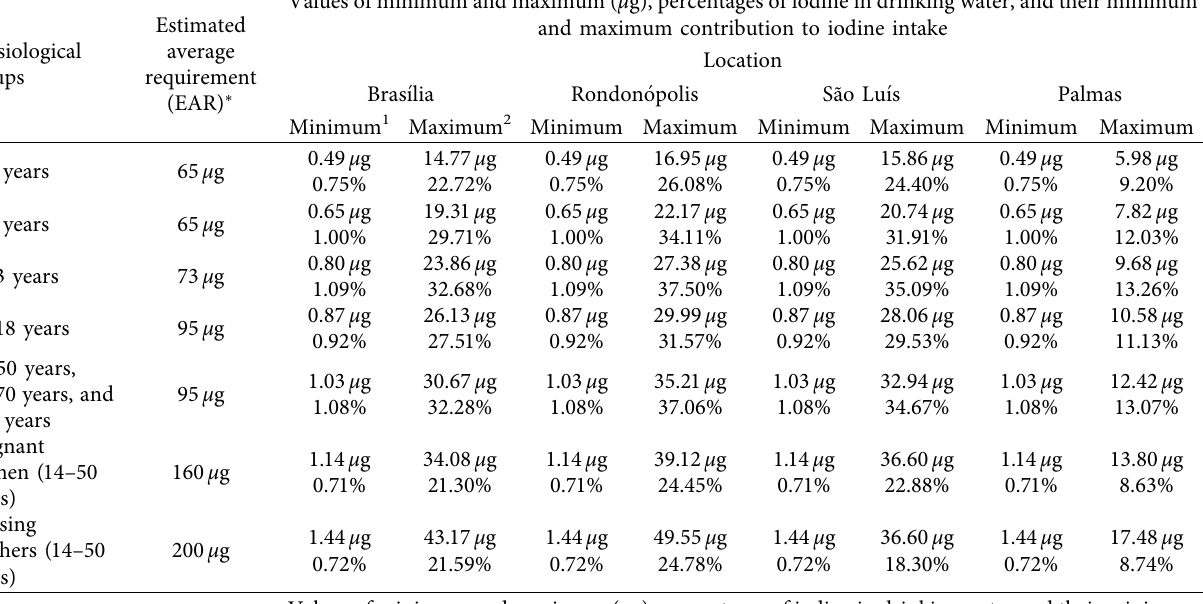
Table 4: Values of minimum and maximum iodine concentrations ( μ g), percentages of iodine in drinking water from diferent locations, and their minimum and maximum contribution to iodine intake among diferent physiological groups. Values of minimum and maximum ( μ g), percentages of iodine in drinking water, and their